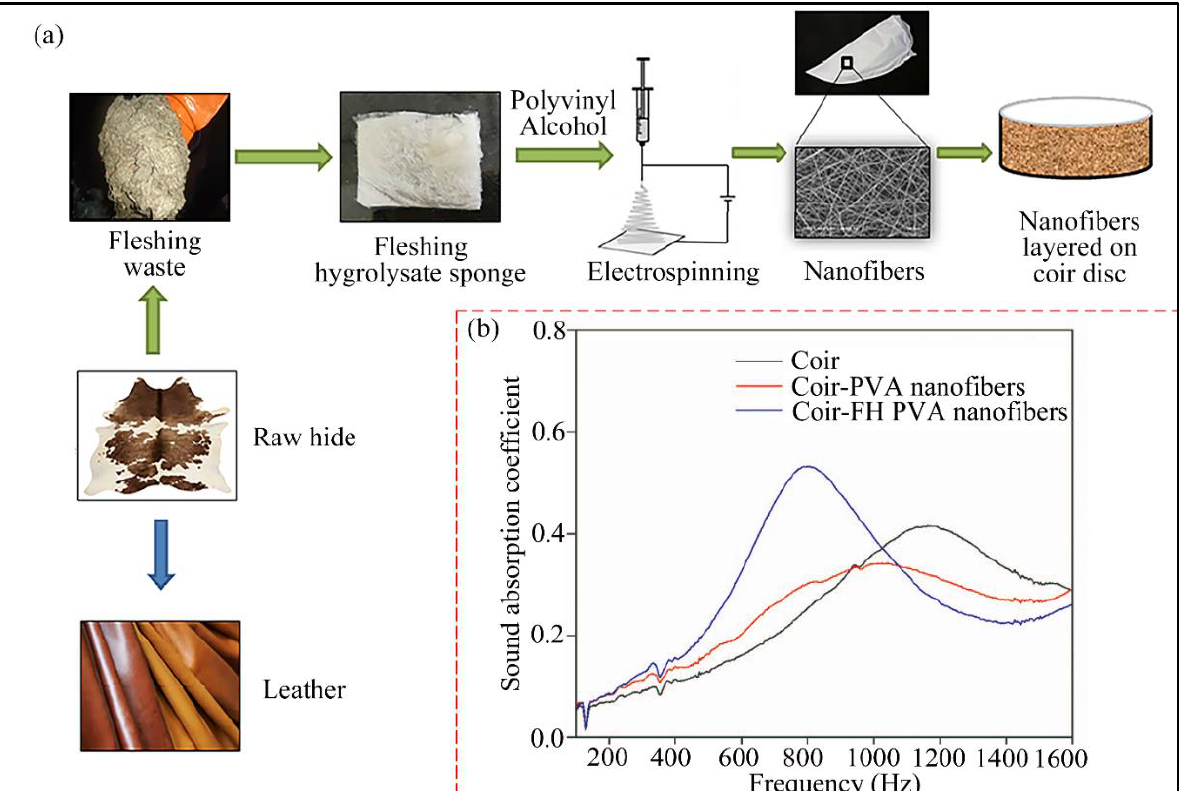
Figure 4. ( a ) The preparation process of nanofibers and coir composites by electrospinning; ( b ) The sound absorption coefficients of the samples. Reprinted with permission from ref. [75]. Copyright 2019 Elsevier.